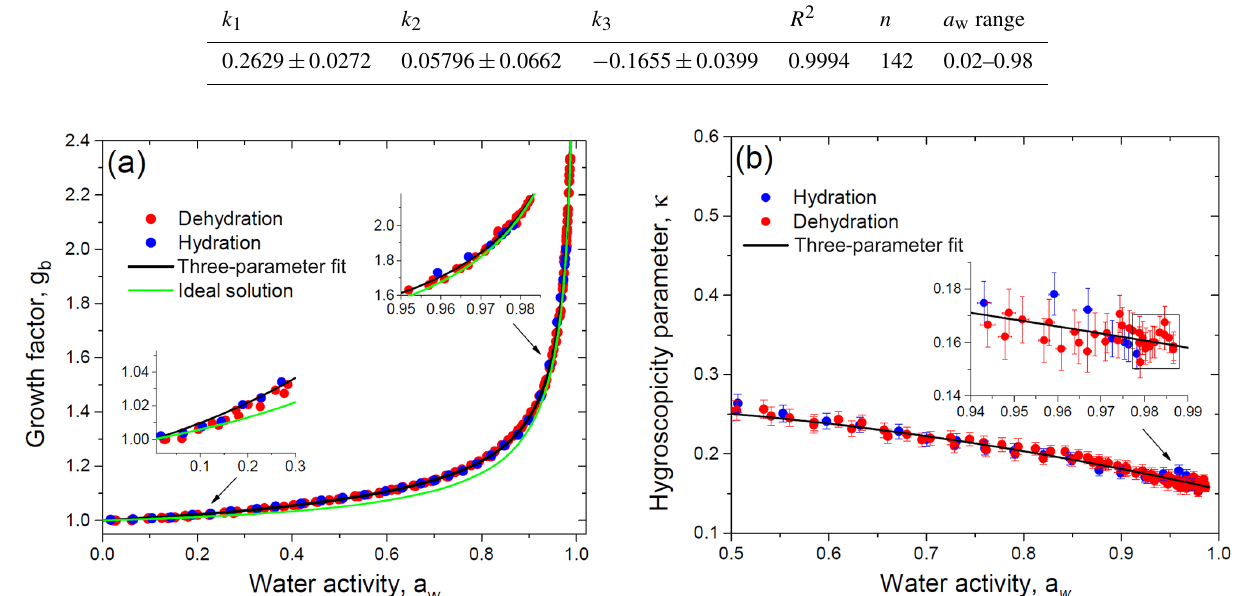
Figure 11. Growth factor (a) and hygroscopicity parameter (b) of glucose aerosol particles as a function of water activity. Black lines in panels (a) and (b) correspond to the three-parameter fit using Eqs. (17) and (19), respectively. The green line accounts for the ideal solution model (a) . Insets: (a) water-activity-based growth factors at low and high a w in comparison with model curves; (b) hygroscopicity parameter change at a w above 0.94. The data points selected by the rectangle are used to calculate the average value of the dilute hygroscopicity parameter, κ